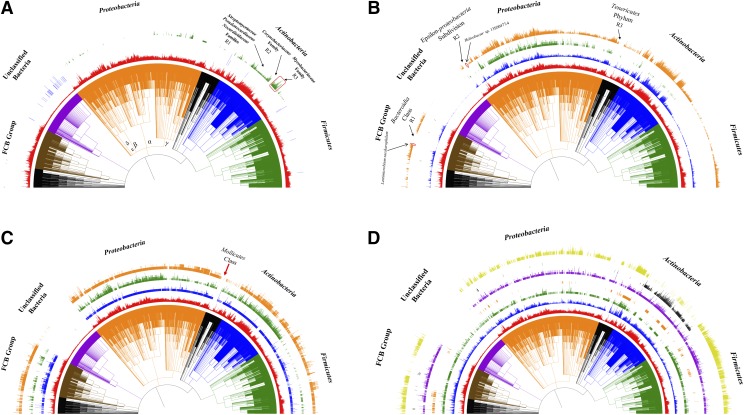
Distribution patterns of key enzymes and representative pathways along the NCBI taxonomy ID-based phylogenetic tree. (A) Distribution of key enzyme WS/DGAT (green circle) and PDAT (blue circle), together with bacterial proteome sizes (red circle); (B) distribution of the classical PHA synthesis pathway PhaABC (orange circle) and the two groups of PHA synthases, Group I with Abhydrolase_1 domain (blue circle) and Group II with PhaC_N domain (green circle); (C) distribution of key enzyme polyphosphate kinase PPK1 (blue circle), polyphosphate kinase 2 PPK2 (green circle), and exopolyphosphatase PPX (orange circle); (D) distribution of two glycogen synthesis pathways and four key enzymes, that is, classical synthesis pathway (yellow circle) including GlgC, GlgA, and GlgB, trehalose-based glycogen synthesis pathway including TreS, Pep2, GlgE, GlgB (black circle), glycogen synthases (Rv3032 in blue circle and GlgA in green circle) and glycogen branching enzymes (GH57 GlgB in orange circle and GH13 GlgB in violet circle). Five groups of bacteria are highlighted, which are Firmicutes (green), Actinobacteria (blue), Proteobacteria (orange), Unclassified Bacteria (violet), and FCB group (brown).